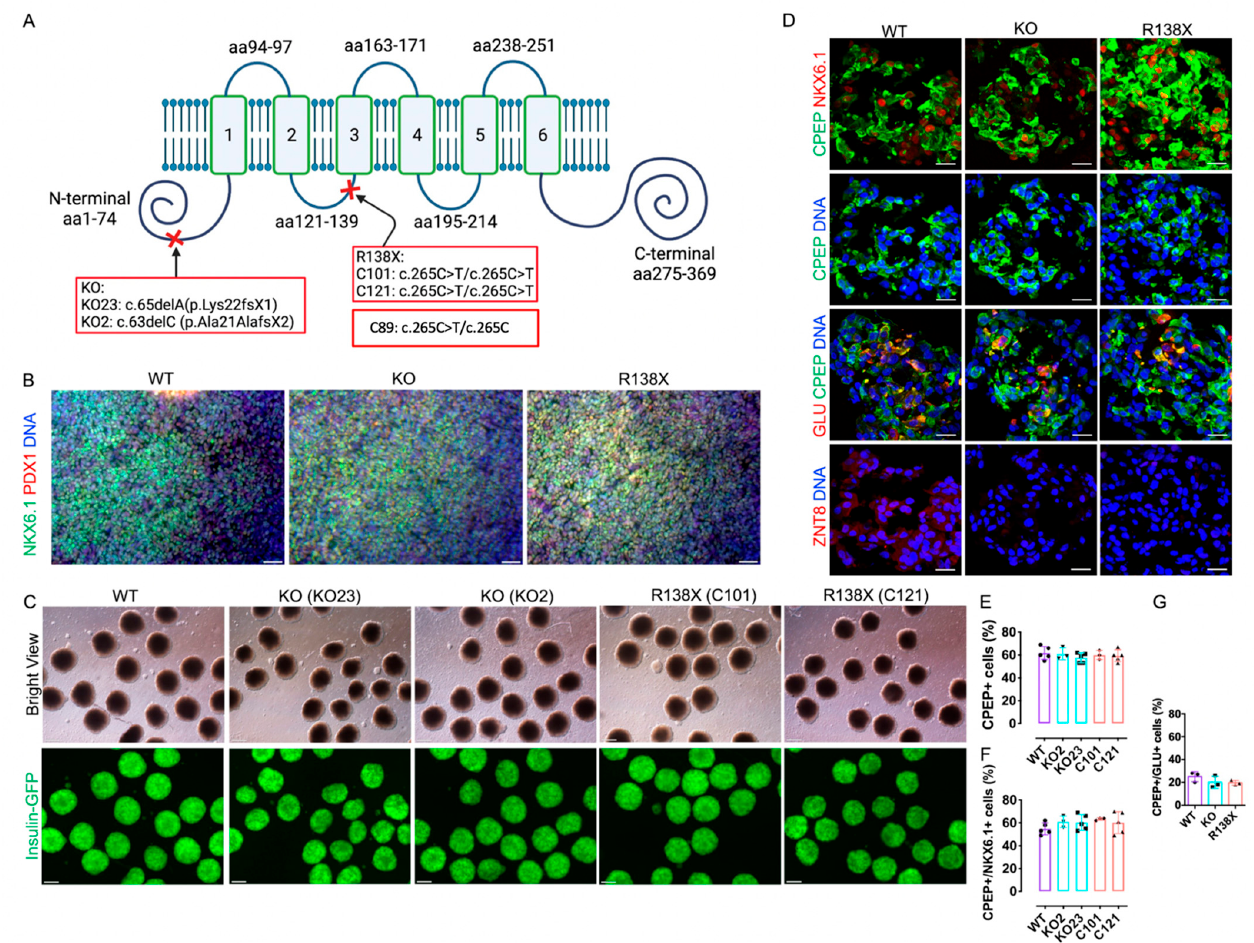
Figure 1. Human pluripotent stem cells with R138X and KO mutation differentiate efficiently to insulin-producing cells. ( A ) Schematic of introduced SLC30A8 KO mutation (clone KO23: c.65delA/p.Lys22fsX1 and KO2: c.63delC/p.Ala21AlafsX2) and R138X mutation (clone C121: c.265C > T/c.265C > T and C101: c.265C > T/c.265C > T). Adapted from [21]. ( B ) Representative fluorescence picture of stem cell-derived pancreatic progenitor cells on day 12 of differentiation stained for PDX1, NKX6.1, and Hoechst. Scale bar: 50 μ m. ( C ) Representative bright field view and fluorescence picture of islet-like clusters derived from WT, two KO clones (KO2 and KO23), and two R138X clones (C101 and C121) on day 27 of differentiation. Scale bar: 100 μ m. ( D ) Immunofluorescence of WT,